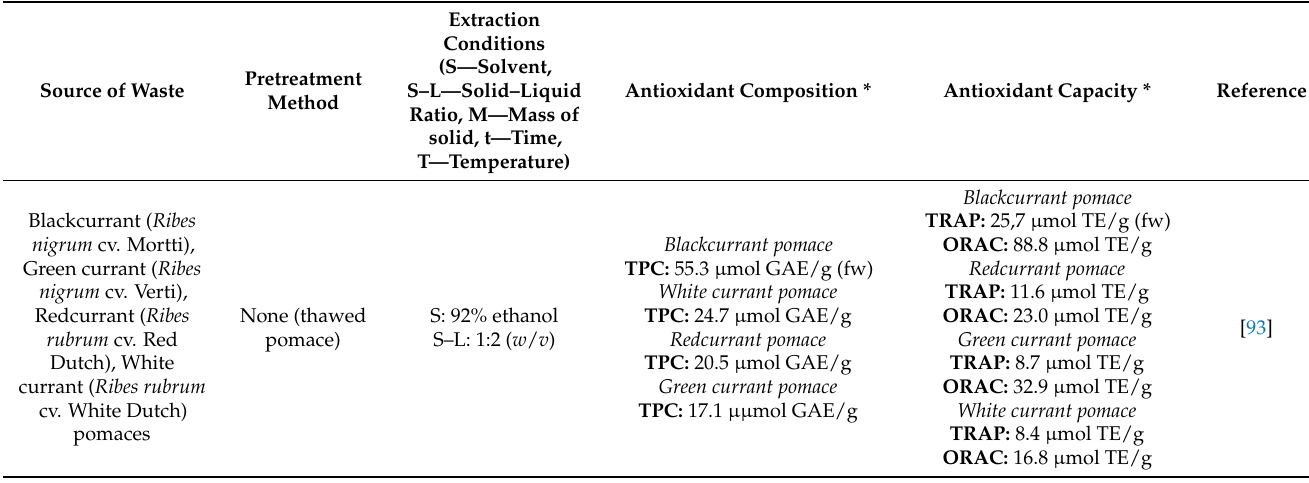
Table 5. Antioxidant composition and capacity of berry by-product extracts obtained with the use of conventional